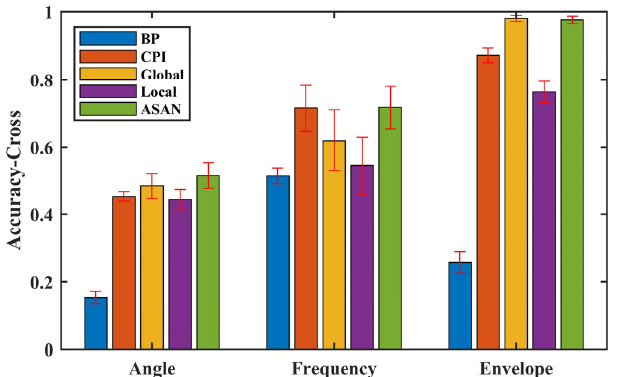
Figure 7. Cross-condition diagnostic performance of different methods under three input data.